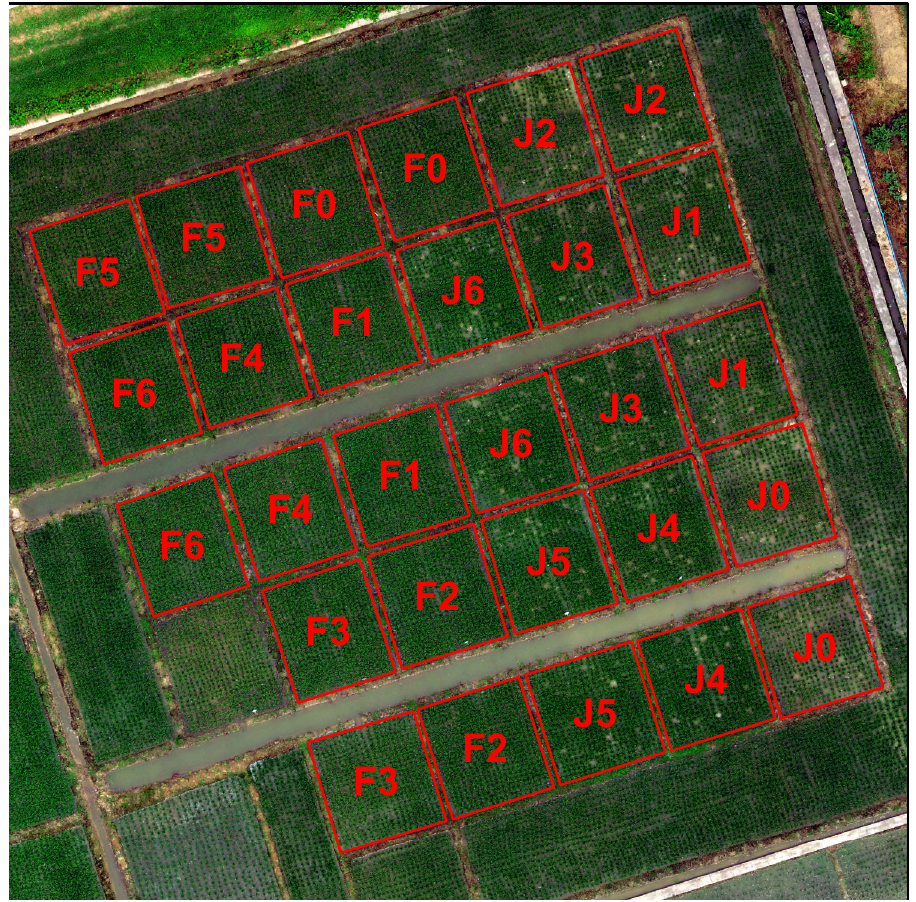
Figure 1. Demonstration of plot distribution, plot boundaries and nitrogen treatment leaves. J 0 − J 6 received 0, 30, 60, 90, 120, 150 and 180 (kg ha − 1 ) nitrogen, respectively, at 7 d after transplantation (DAT); F 0 − F 6 each received 90 (kg ha − 1 ) nitrogen at DAT 7; F 0 − F 6 received 0, 15, 30, 45, 60, 75 and 90 (kg ha − 1 ) nitrogen, respectively, at DAT 33. The red rectangles are plot